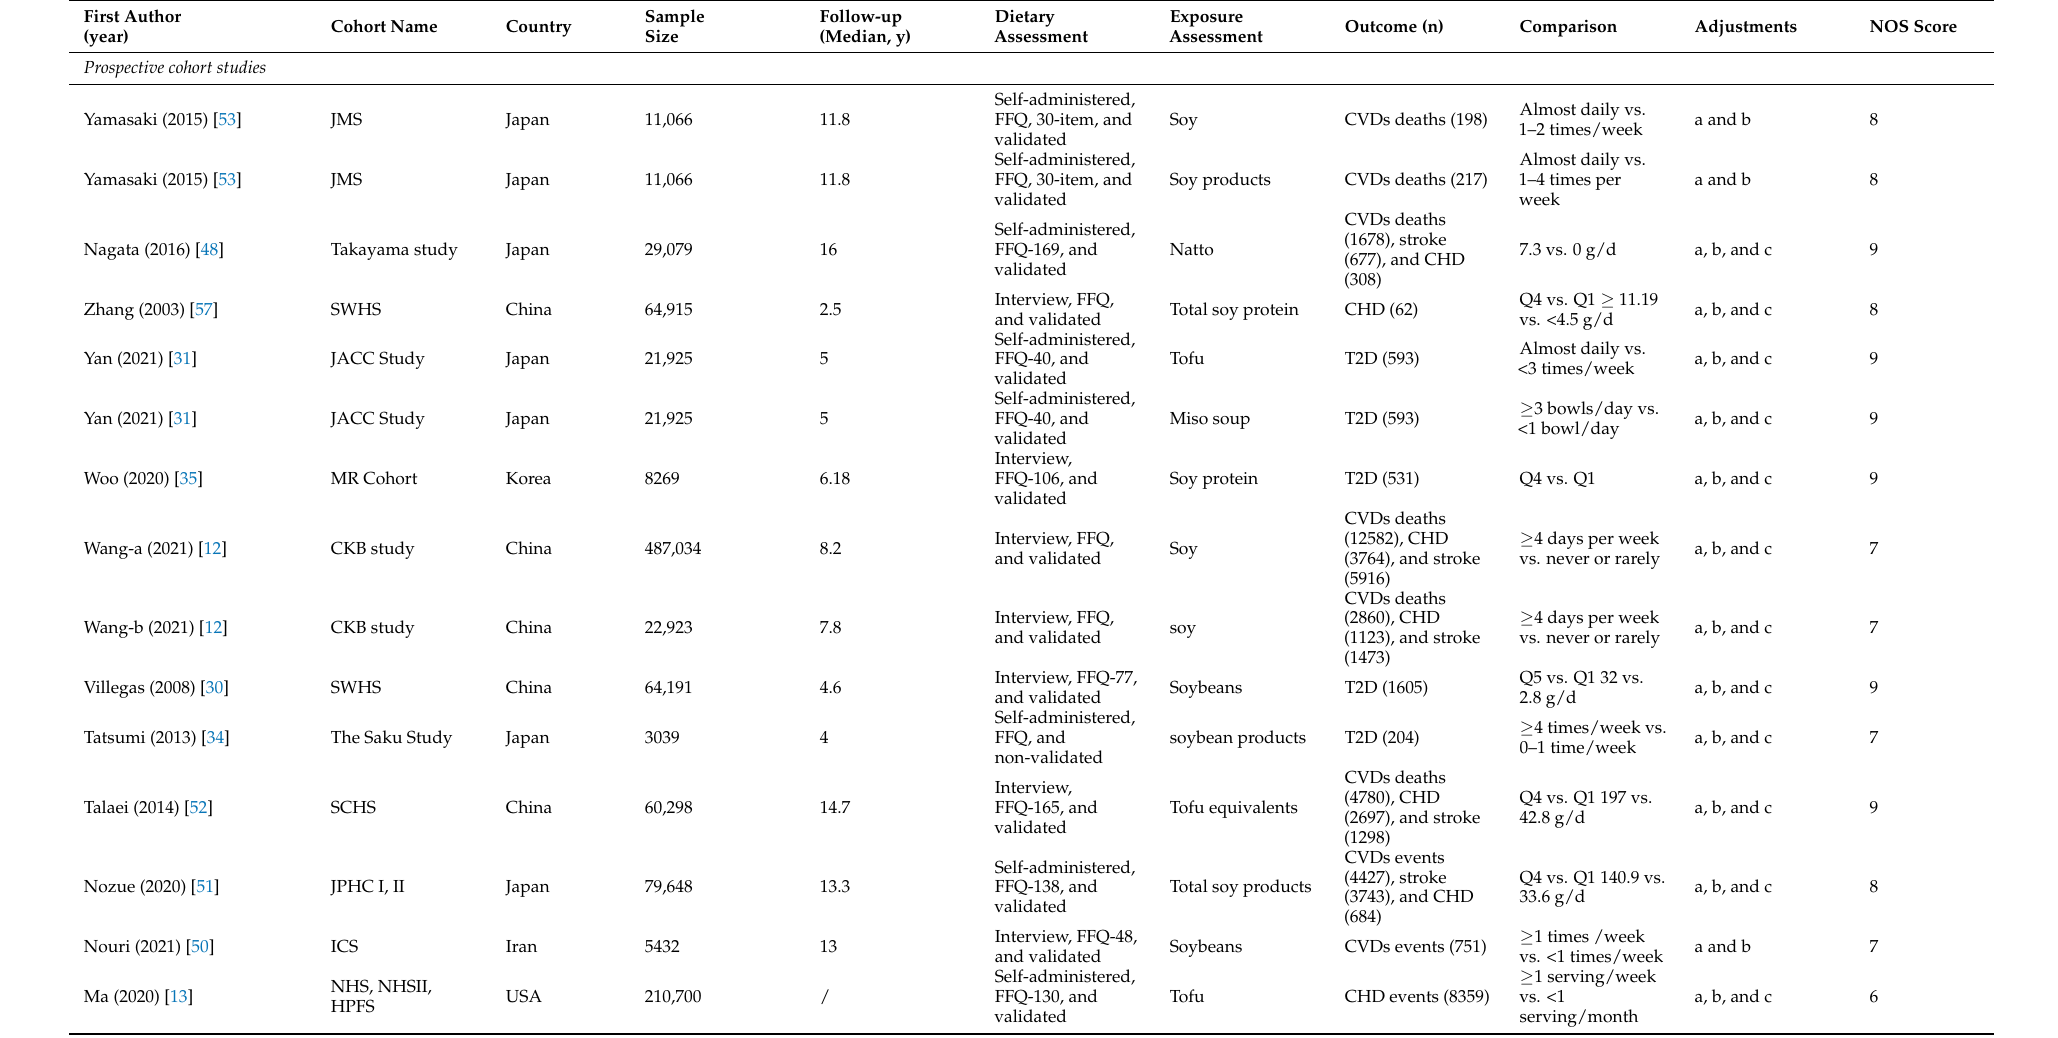
Table 1. Basic characteristics of the included prospective and case–cohort studies by exposures